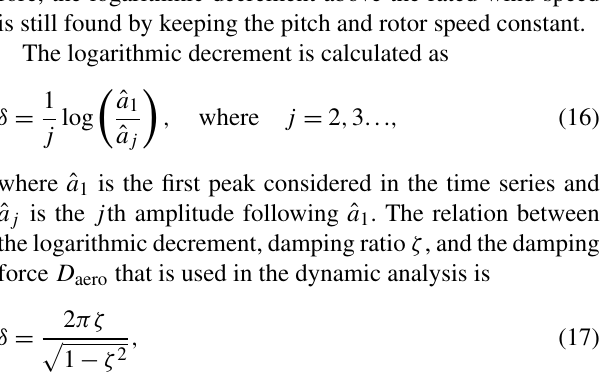
Figure 8. The damping ratio as a function of wind speed for differ- ent decay